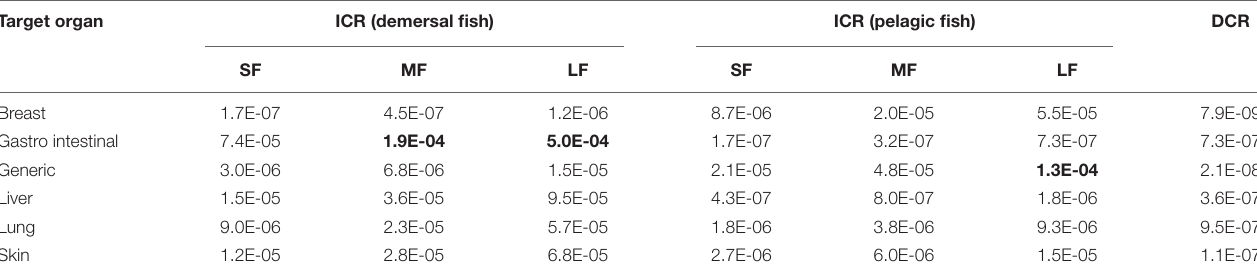
TABLE 5 | Combined Ingestion Cancer Risk for small (SF), medium (MF), large (LF) demersal-pelagic fishes, and Combined Dermal Cancer Risk calculated for the target organ of each carcinogenic contaminant. Target